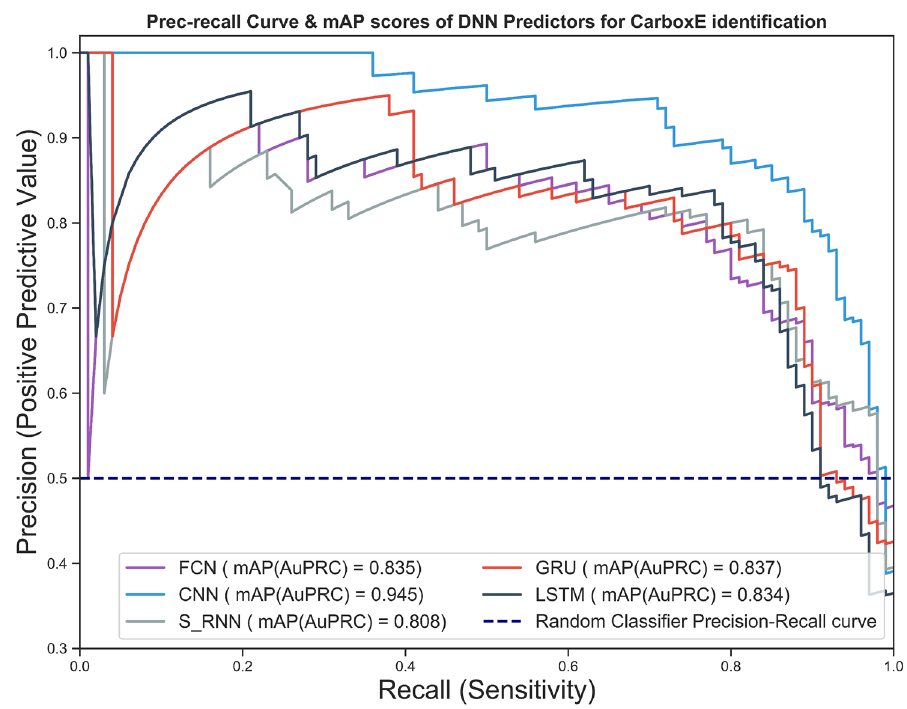
Figure 2. Precision-recall curve and mAP scores DNN-based CarboxE site prediction models.